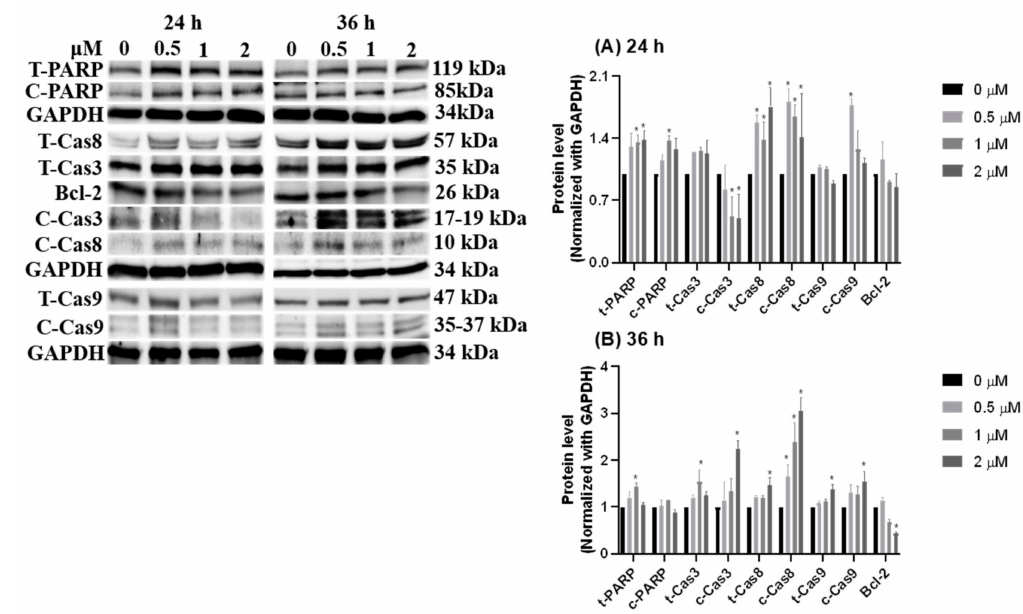
Figure 5. Dynamic change of apoptotic markers after HCD treatment. The protein levels of PARP, caspase-3, caspase-8, and caspase-9 were measured after ( A ) 24 h and ( B ) 36 h of HCD treatment. The protein levels were represented as the ratio of GAPDH-normalized chemiluminometric intensity between the untreated control (0 µ M) and treatment. Data ( n = 3) were represented as mean ± SD. * p < 0.05 as compared with the untreated control (0 µ